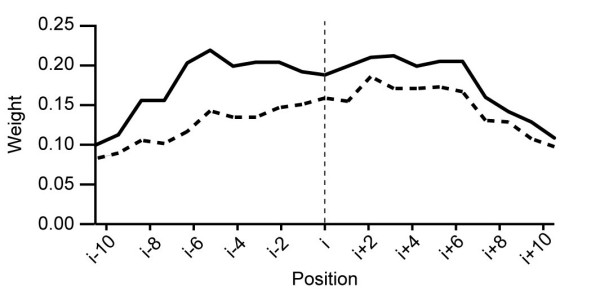
Positional weighting profiles associated with the LRG (dashed line) and PHAT (solid line) matrices.